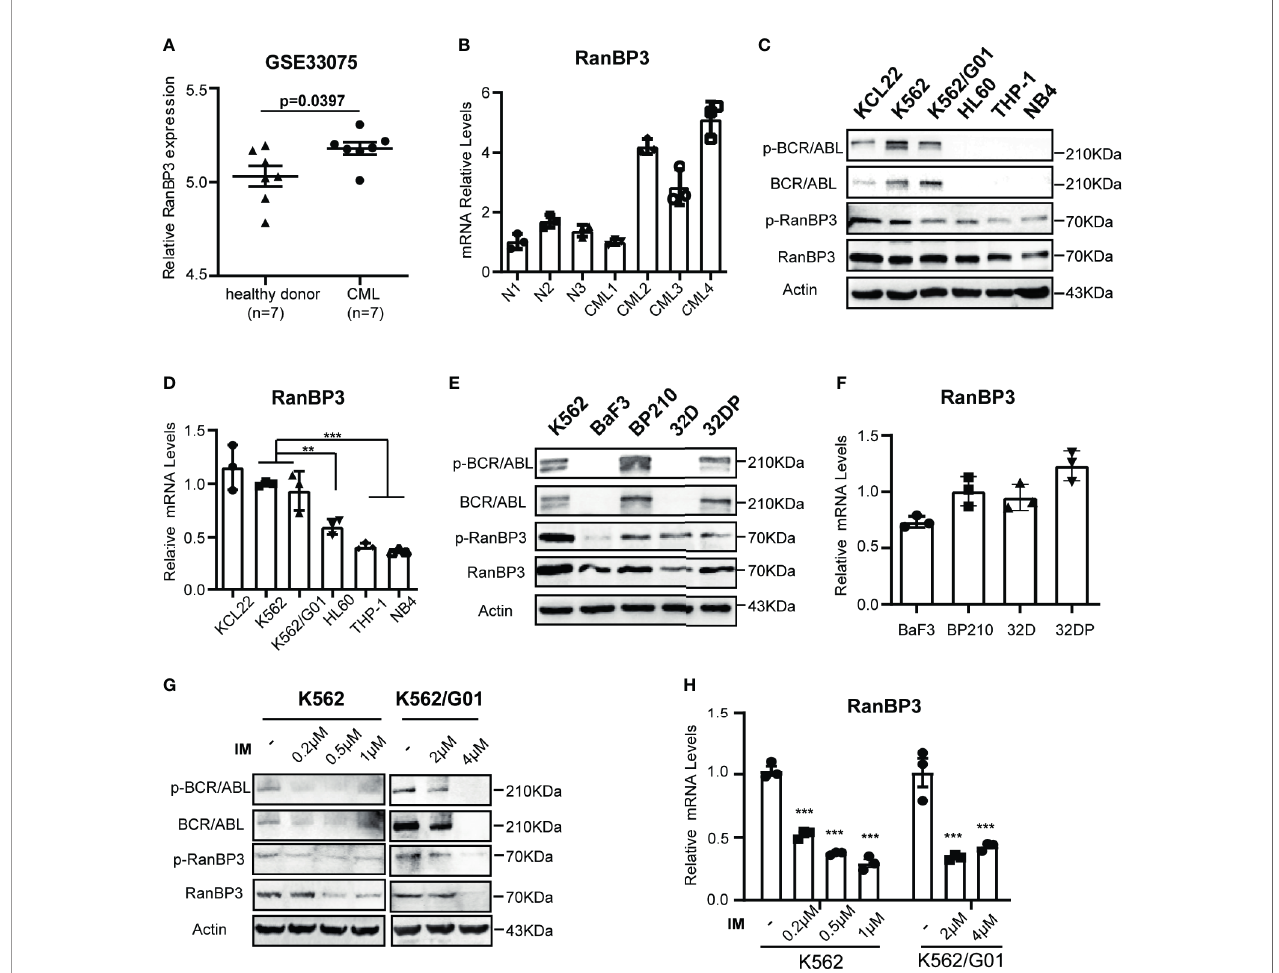
FIGURE 1 | Expression of RanBP3 is up-regulated in CML. (A) The RanBP3 mRNA level was analyzed in database GSE33075, including 9 healthy individuals and 9 CML patients. After removing the outliers of each group, 7 samples of each group were used for expression analysis. (B) Bone marrow mononuclear cells separated from 3 normal controls and 4 CML patients were used to assess the mRNA levels of RanBP3. (C) The protein levels of RanBP3 were detected in BCR-ABL positive cells K562, K562/G01, KCL22 and BCR-ABL negative cells HL60, THP-1 and NB4. (E) The protein levels of RanBP3 in BCR-ABL transformed mouse cell lines and their corresponding control cells. (D, F) The mRNA levels of RanBP3 correspond to cells in (C) and (E) . (G, H) K562 and K562/G01 cells were treated with various concentrations of IM for 48 hours and the protein (G) and mRNA (H) levels of RanBP3 in these cells were detected. **P < 0.01, ***P <